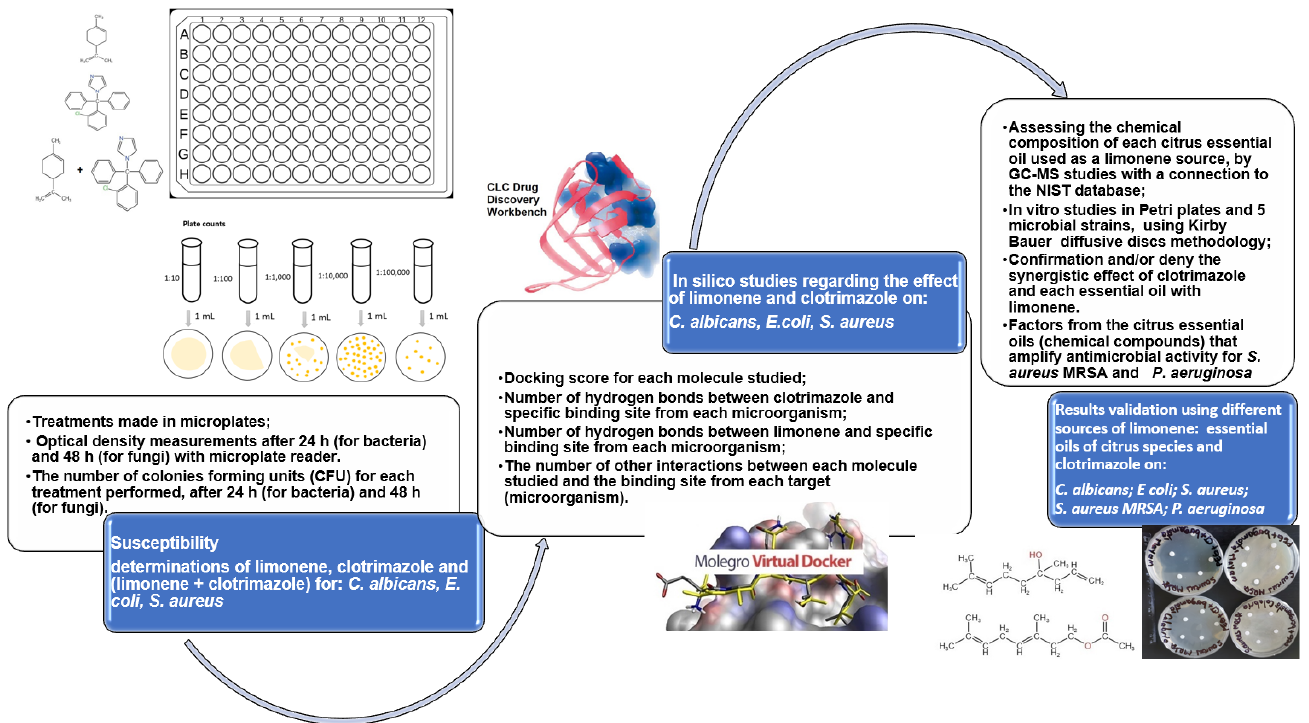
Figure 1. The methodology presented in studies regarding the antimicrobial behavior of clotrimazole and limonene.